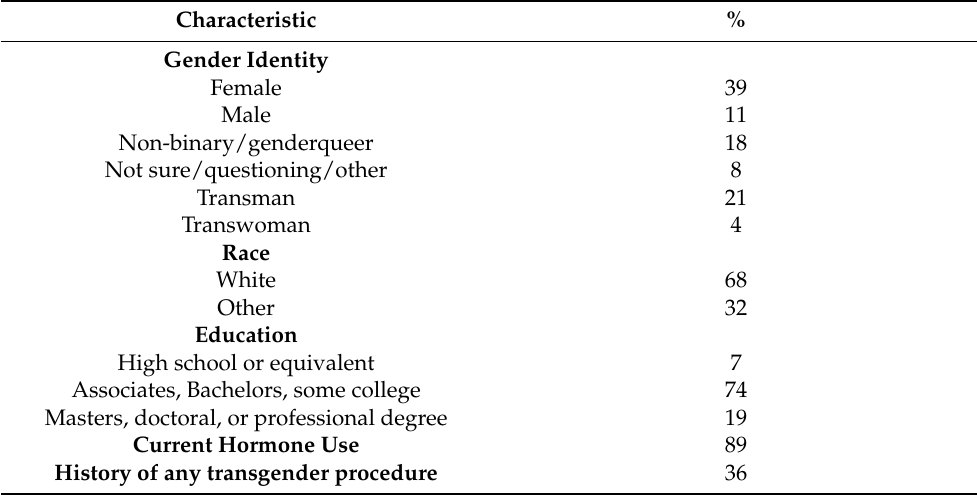
Table 3. Description of transgender patient focus group participants ( N =